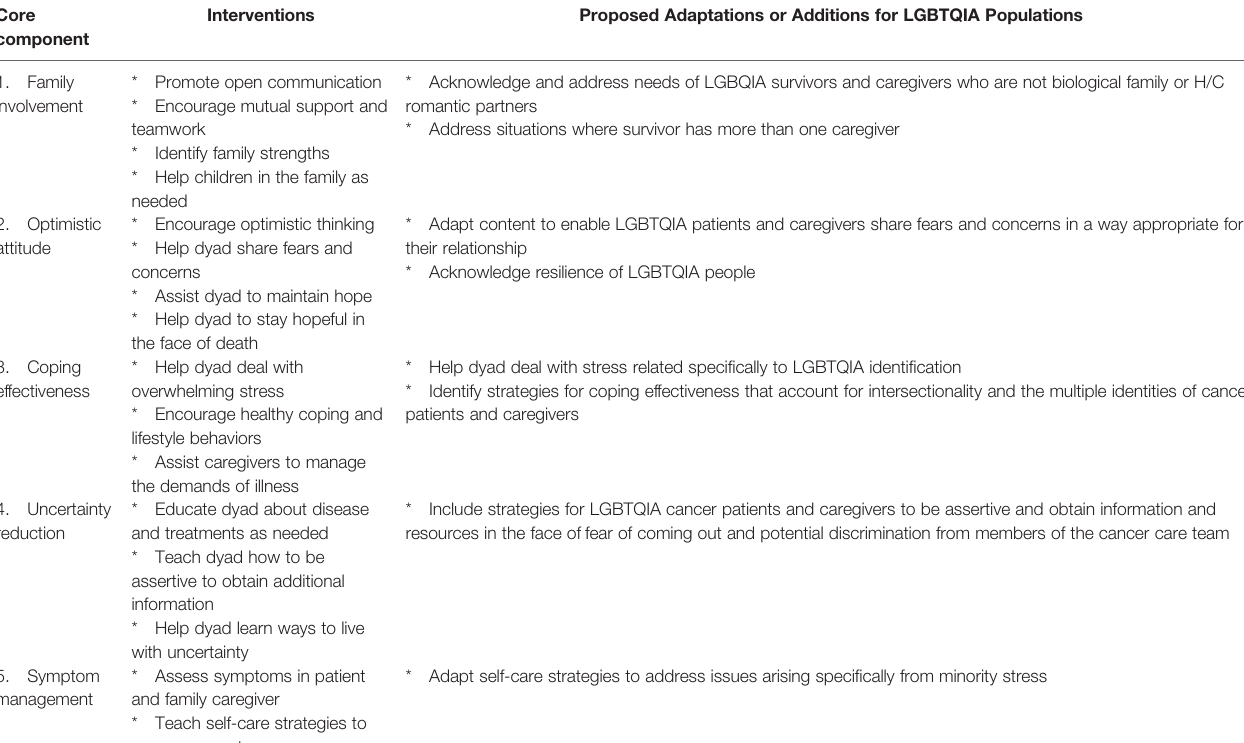
TABLE 3 | Core components of the FOCUS program and potential adaptations for LGBTQIA cancer survivors and caregivers (adapted from Northouse, et al., 2005)(50). Core component